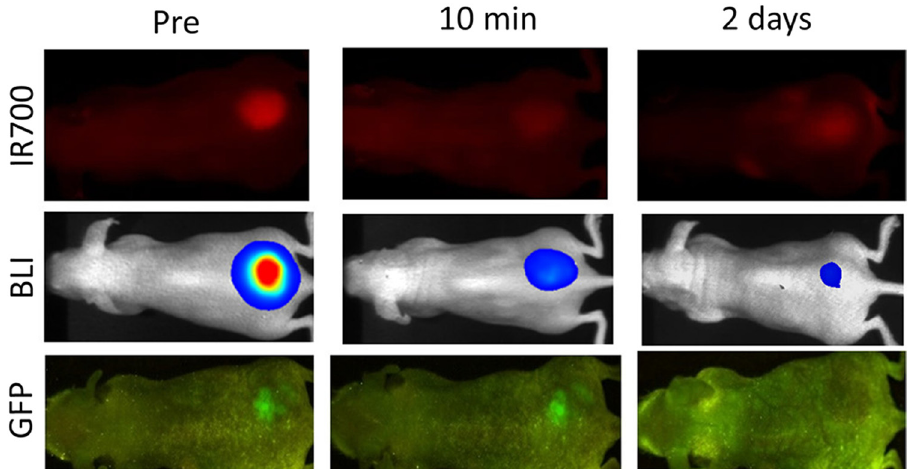
Figure 12: In vivo monitoring of photoimmunotherapy e ff ects. Real - time images of A431 - luc - GFP tumor - bearing mice. Before NIR - PIT panitumumab - IR700 ( red ) accumulates in the tumor. Immediately after irradiation, the fl uorescence decreases, while after 48 h, it shows an increase ( probably due to the injection of PICs into the tumor region ) . Luciferase – luciferin photon counting ( color gradient ) gradually decreased, indicating progressively cell death. Immediately after irradiation, GFP fl uorescence ( green ) is almost constant, but after 48 h, it shows a strong decrease ( suggesting cell death ) . Reprinted with permission from Maruoka et al. [ 119 ] . Copyright 2017 American Chemical